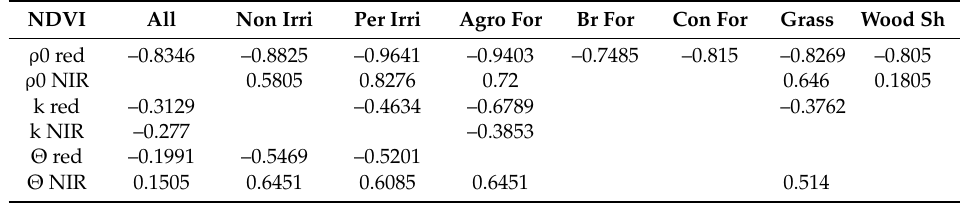
Table 3. Spearman correlation coefficient from the NDVI and each of the MRPV parameters. In the second column, the Rho’s from all seven MISR orbit pixels is shown. Missing cells indicate non-significant Spearman